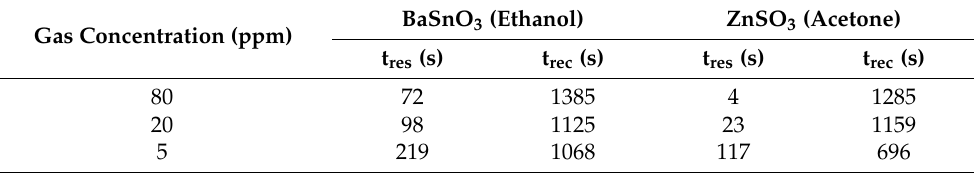
Table 1. Response (t res ) and recovery (t rec ) times of the BaSnO 3 and ZnSnO 3 sensors exposed to different gas concentrations of ethanol and acetone, respectively, at operating temperature of 270 ◦ C. Results based on Figure 12.